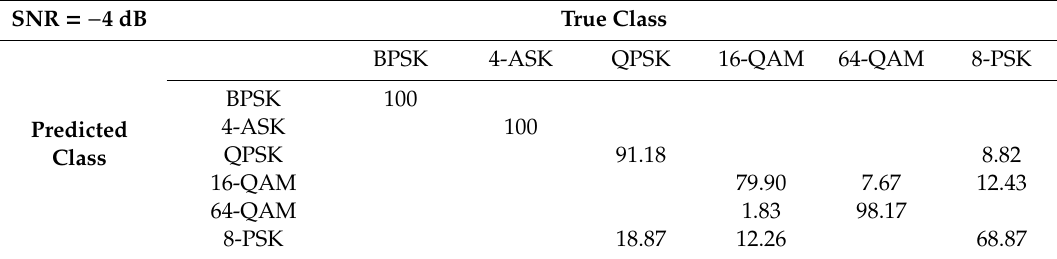
Table 2. Confusion Matrix of NSVM at SNR = − 4 dB.